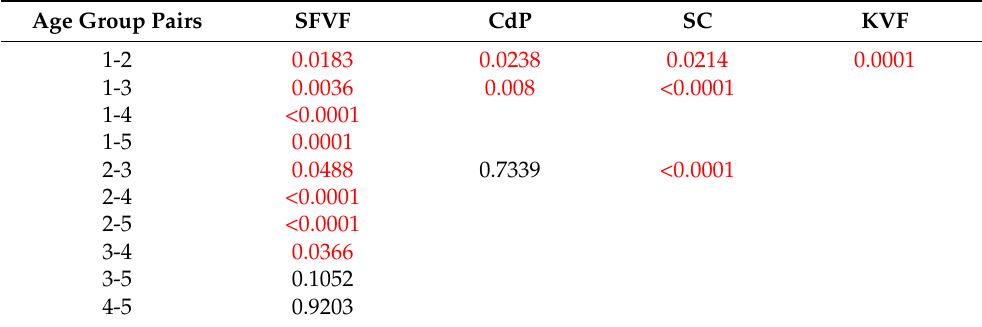
Table 2. Calculated p values of average slope for each group pairs (grouped by areas). Significant differences are in